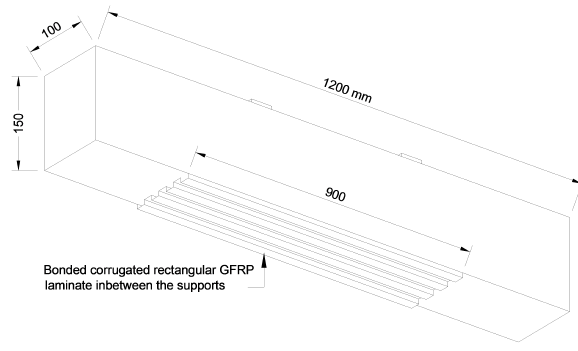
Figure 3: Beam strengthened with rectangular corrugated GFRP